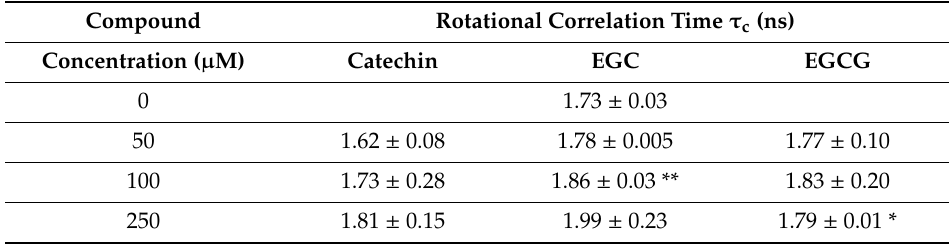
Table 2. E ff ect of catechins on the rotational correlation time (in nanoseconds) of 16-doxyl-stearic acid in erythrocyte membranes. Mean values ± SD, n ≥ 3.